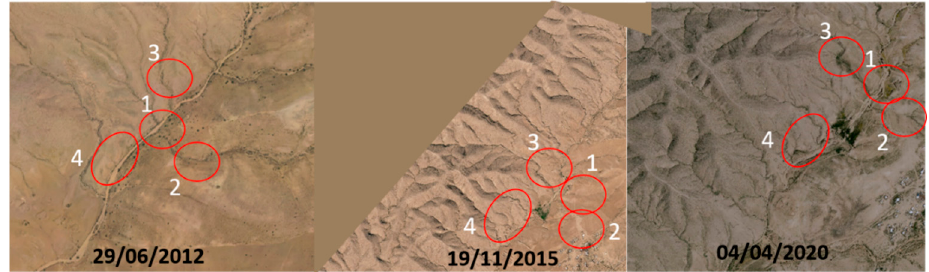
Figure 5. Geomorphological and vegetal changes of the site of study in the last decade (2012, 2015, 2020).